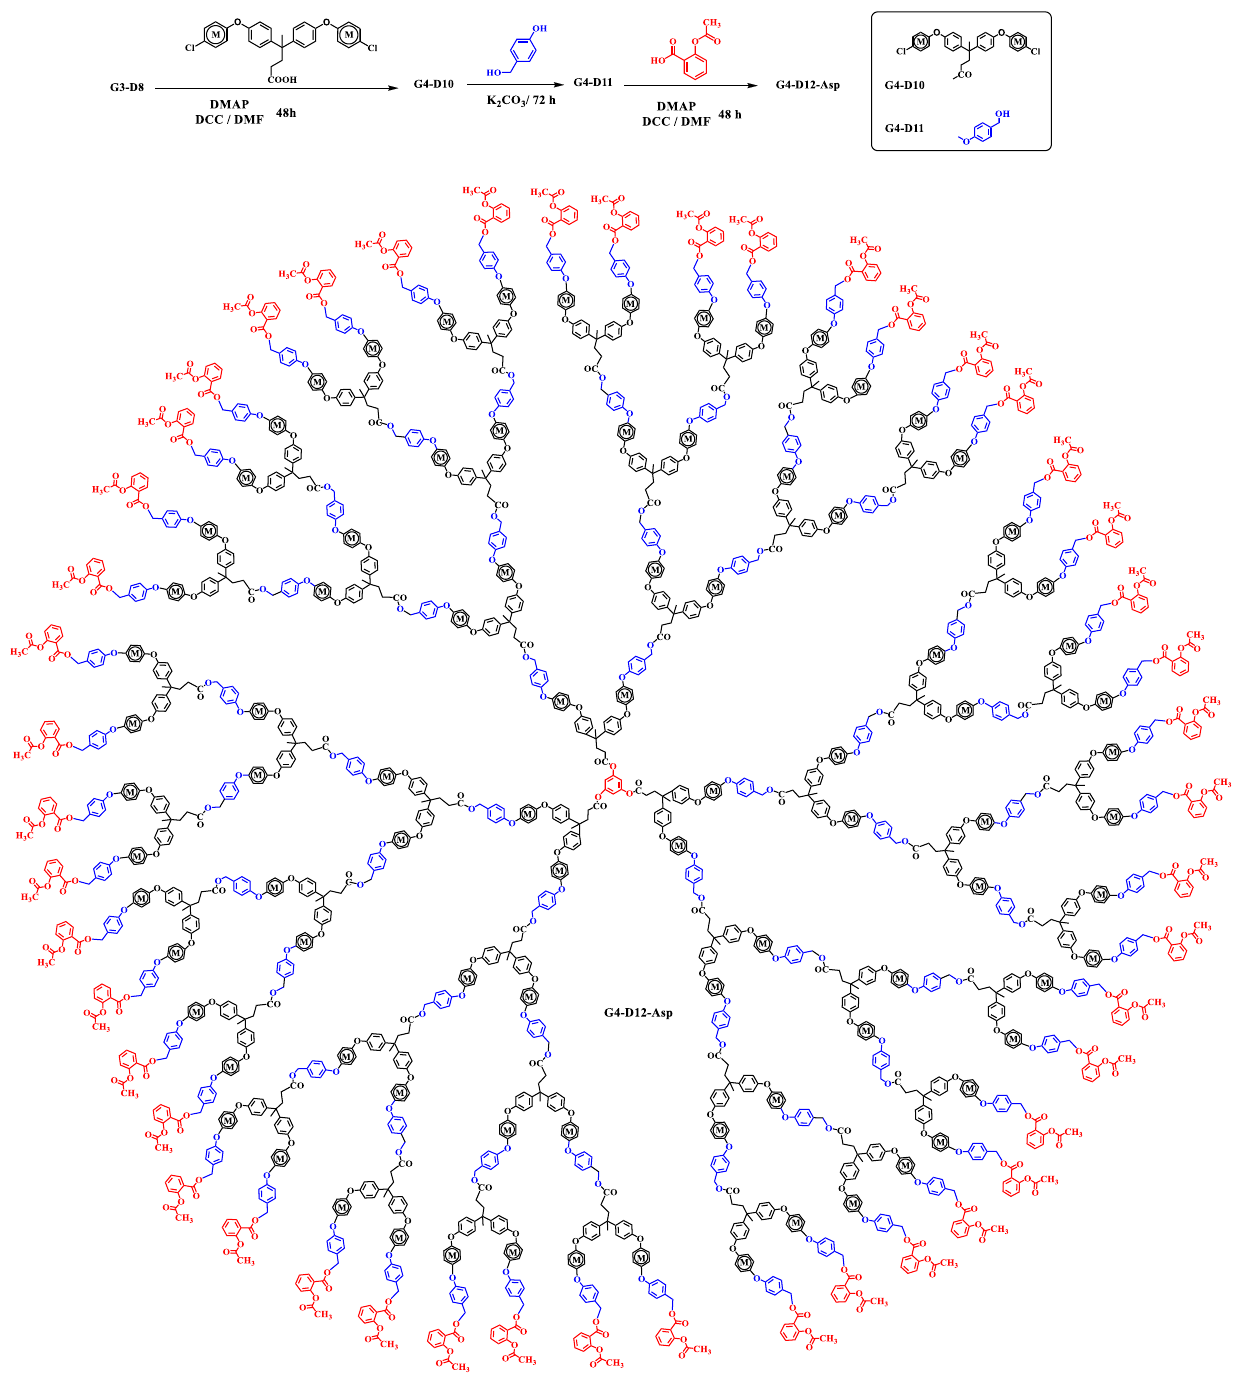
Scheme 4. Schematic representation of the synthesis of G4 -